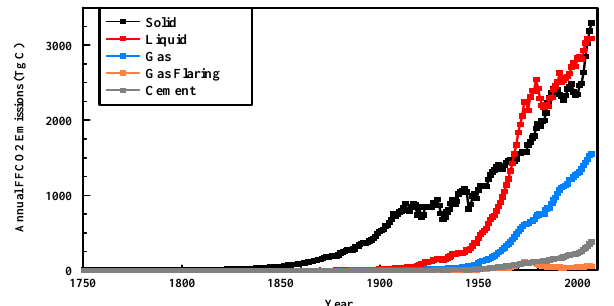
Fig. 1a. The contributions of five sources to FFCO2 emissions for the years 1751 to 2007. This figure was created from the sum of national production values (see section 1) for 15,830 country- year pairs (e.g., the United Kingdom in 1751 is the first country year pair, the United Kingdom in 1752 is the second country-year pair, and Zimbabwe in 2007 is the 15,830th country-year pair). The distribution of country-year pairs is generally increasing with time with the year 1751 containing one country-year pair and 2007 containing 216 country-year pairs. Data richness (e.g., the number of country-year pairs) is increasing with time due to increased energy data availability and the formal recognition of more countries (as there has been a general trend for larger countries to divide into smaller countries (e.g., former USSR)). In 2007, solid fuels accounted for 39% of the 2007 total, liquid fuels 37%, gas fuels 19%, gas flaring 1%, and cement 5% (percentages do not add to 100% due to rounding error). The unit of teragrams carbon (Tg C) is equal to 10 12 grams of carbon. To convert to Tg CO 2 , multiply the total by the molar ratios of carbon dioxide to carbon (44.0/12.0) or 3.67. Data from Boden et al. (2010).